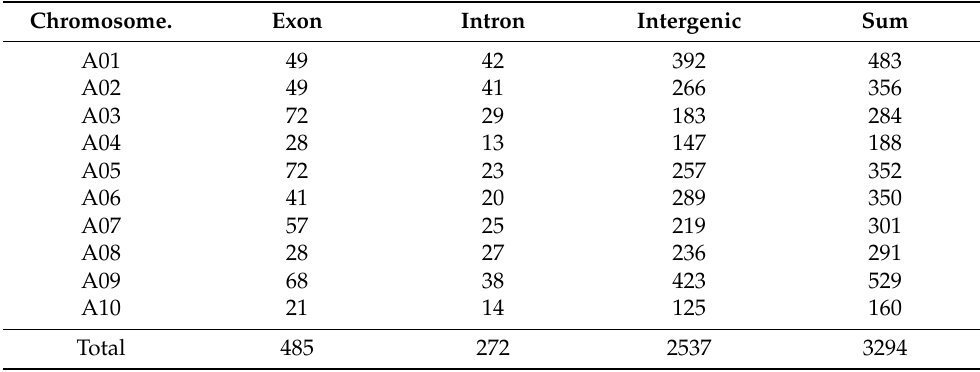
Table 1. Number of the SNPs and InDels in each chromosome commonly identified T 1 and T 3 transgenic Chinese cabbage